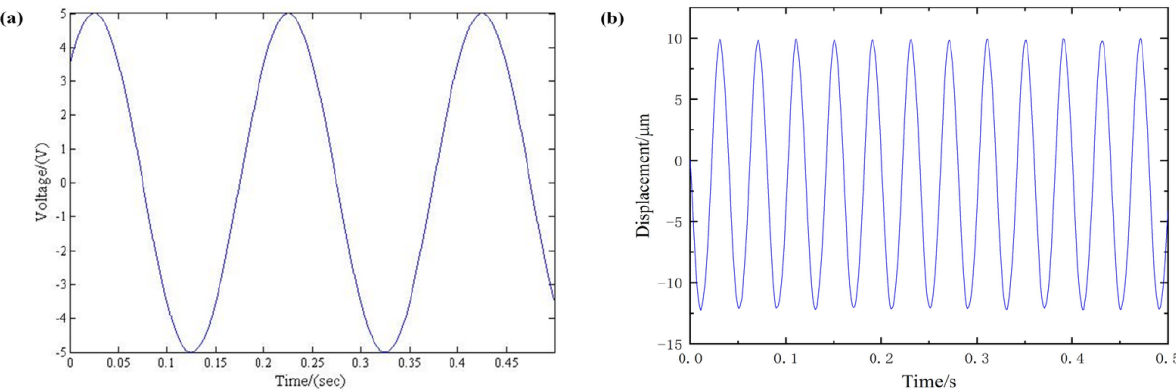
Figure 4. Excitation condition ( a ) sinusoidal excitation signal ( b ) corresponding displacement excitation curve.